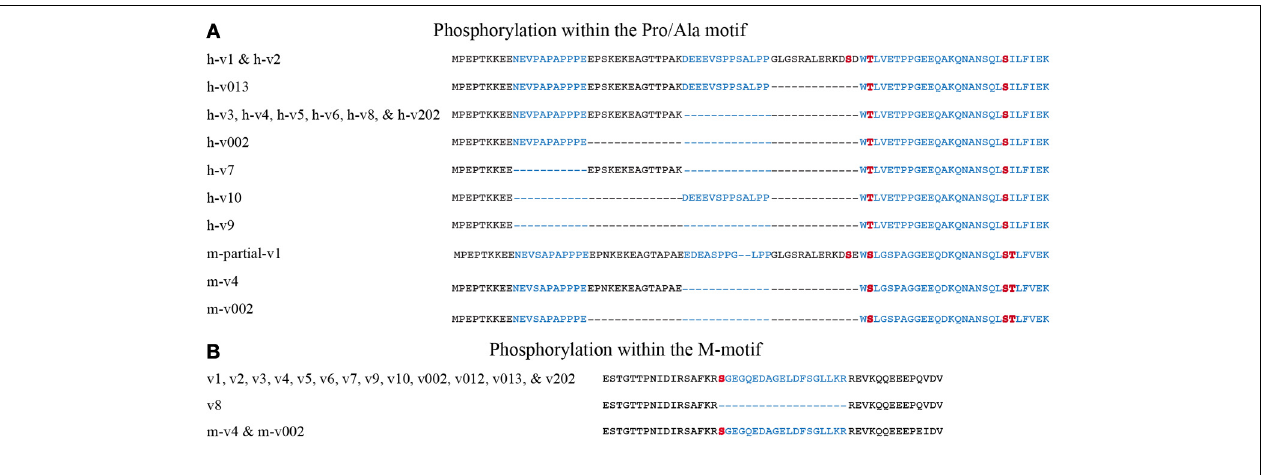
located within a segment that is alternatively spliced and therefore unique to h-v1, h-v2, and the NH 2 -terminus of a partially characterized mouse variant (m-partial-v1) matching that of h-v1 and h-v2. Moreover, human h-ser-206/m-ser-204, located in the M-motif is present in all known sMyBP-C variants, with the exception of h-v8 in which the respective exon (exon 10) is skipped.